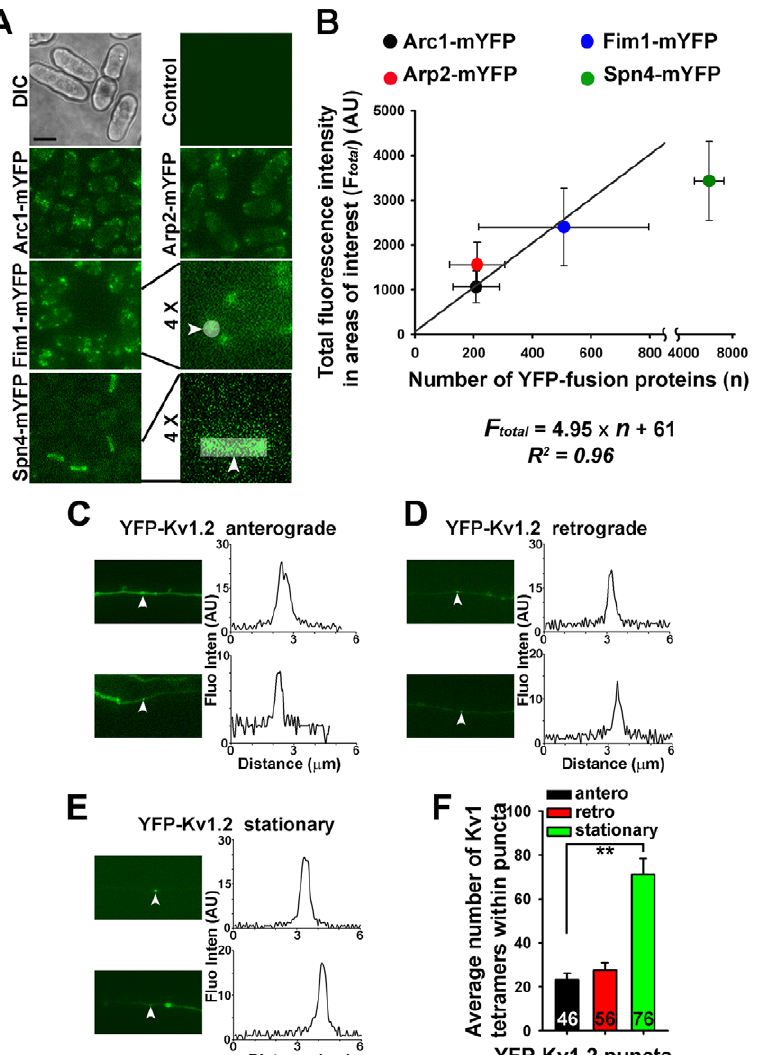
Figure 4. Estimating the number of YFP-Kv1.2 channel tetramers in different transporting vesicles along hippocampal axons. (A) Images of yeast cells. Control cells and the cells expressing Arc1-mYFP, Arp2-mYFP, Fim1-mYFP, and Spn4-mYFP were imaged. Images with 4-fold higher magnification for Fim1-mYFP and Spn4-mYFP are provided on the right. White arrowheads point to the areas of interest. (B) The relationship between the fluorescence intensity (mean 6 SD) of actin patches imaged from our microscope and published numbers of YFP-fusion proteins. A simple linear regression curve was generated. Examples of anterograde moving (C), retrograde moving (D), and stationary (E) puncta (indicated by white arrowheads) of YFP-Kv1.2 along axons are provided. Axonal segments are given on the left, and the fluorescence profile along a 6 m m line across the punctum is given on the right. (F) Average numbers of Kv1 channel tetramers in anterograde (antero, black), retrograde (retro, red), and stationary (green) puncta. **, p , 0.001 in t